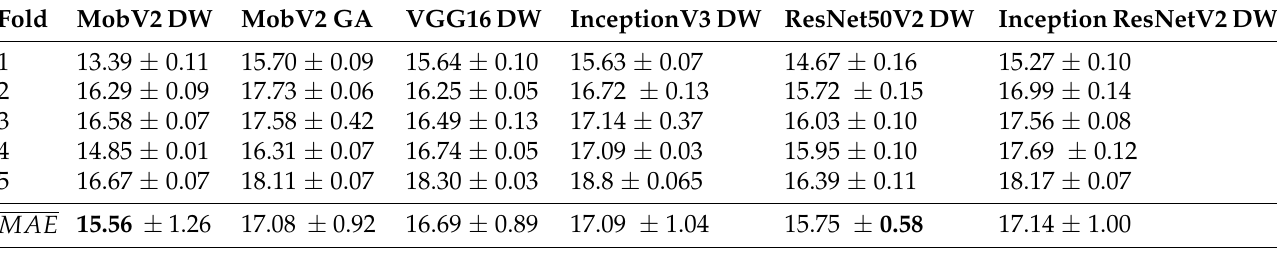
Table 2. Average values and standard deviations of MAE obtained in Experiment I—different models, DXA dataset. The mean MAE and standard deviation in the last row were calculated from all folds.